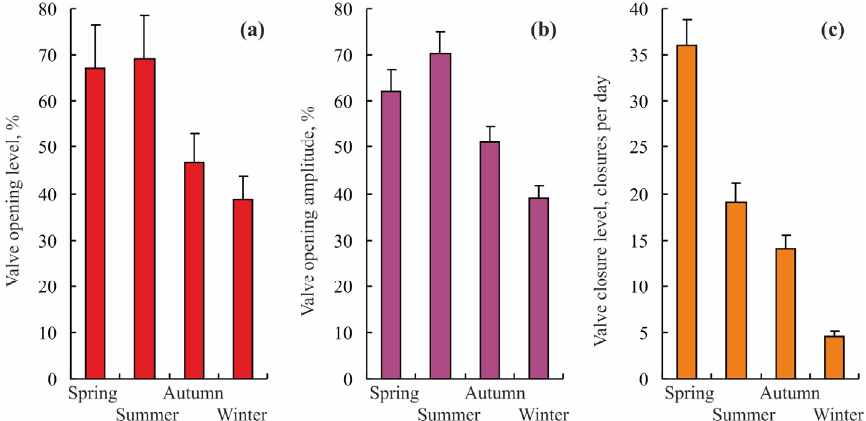
Figure 5. Seasonal changes in valve activity of blue mussels Mytilus edulis from Kola Bay, Barents Sea (modified from [180]). ( a ) valve opening level, ( b ) valve opening amplitude, and ( c ) valve closing frequency.